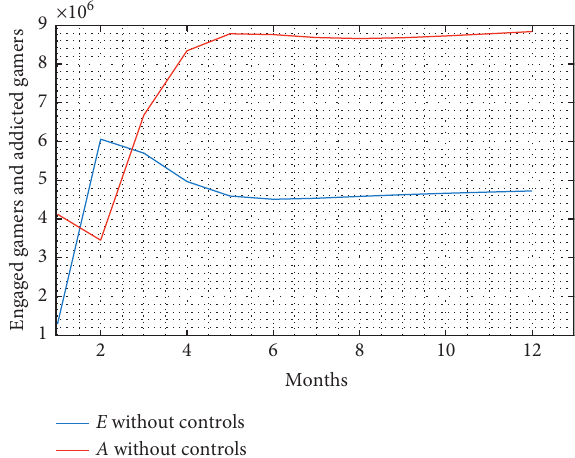
Figure 3: Development of the number of the engaged gamers and the addicted gamers in a few